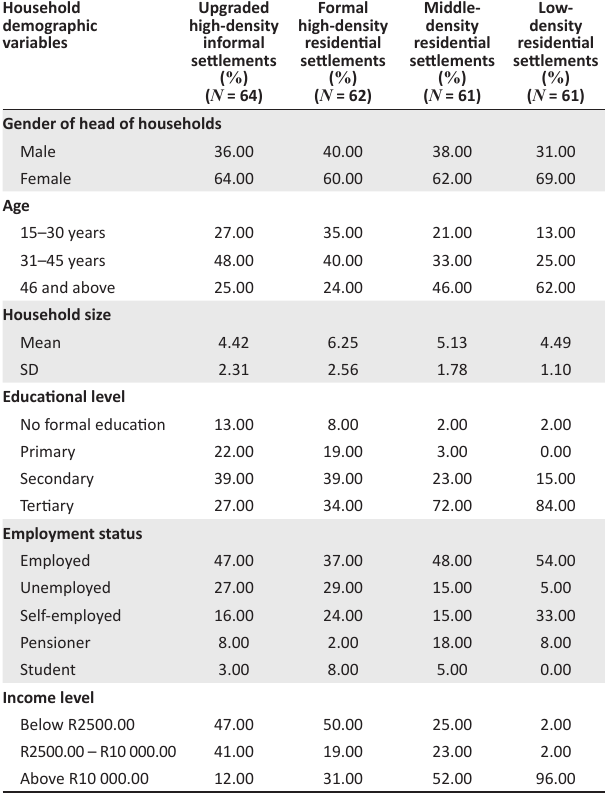
TABLE 2: Household demographics for selected communities – Socio-economic